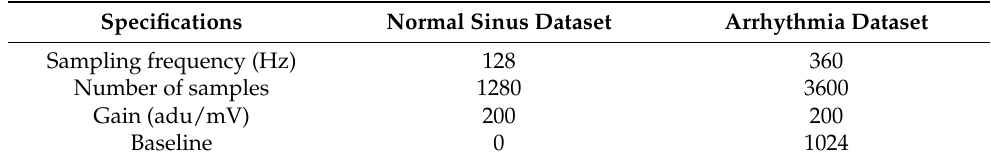
Table 8. ECG signal specifications of the training